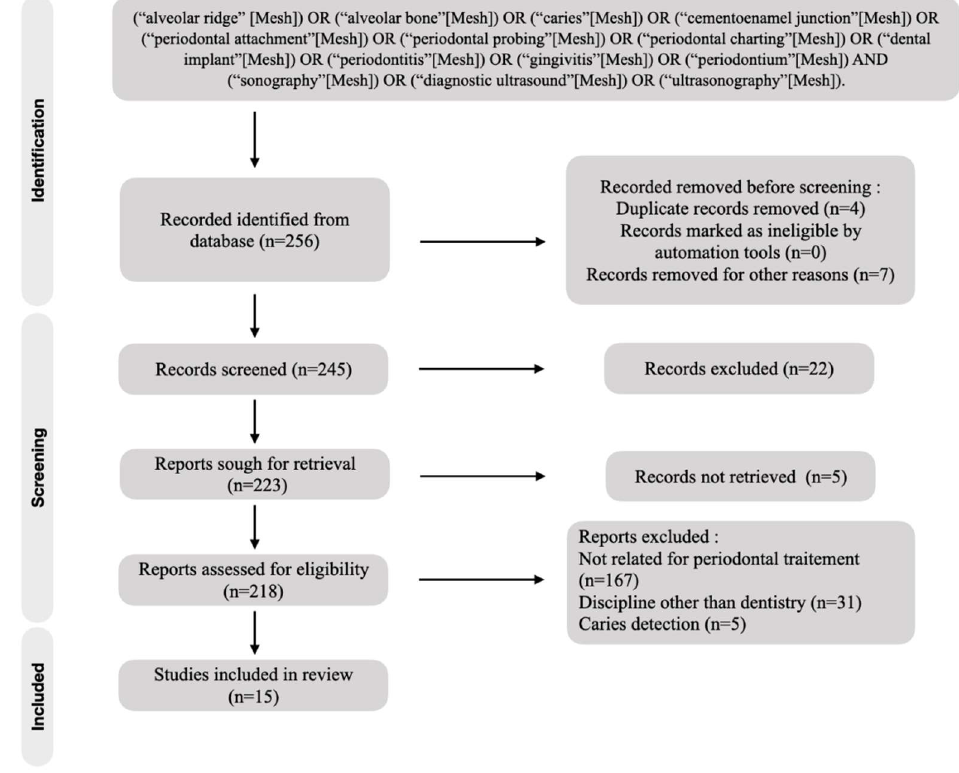
Figure 1. Flow chart of included studies.